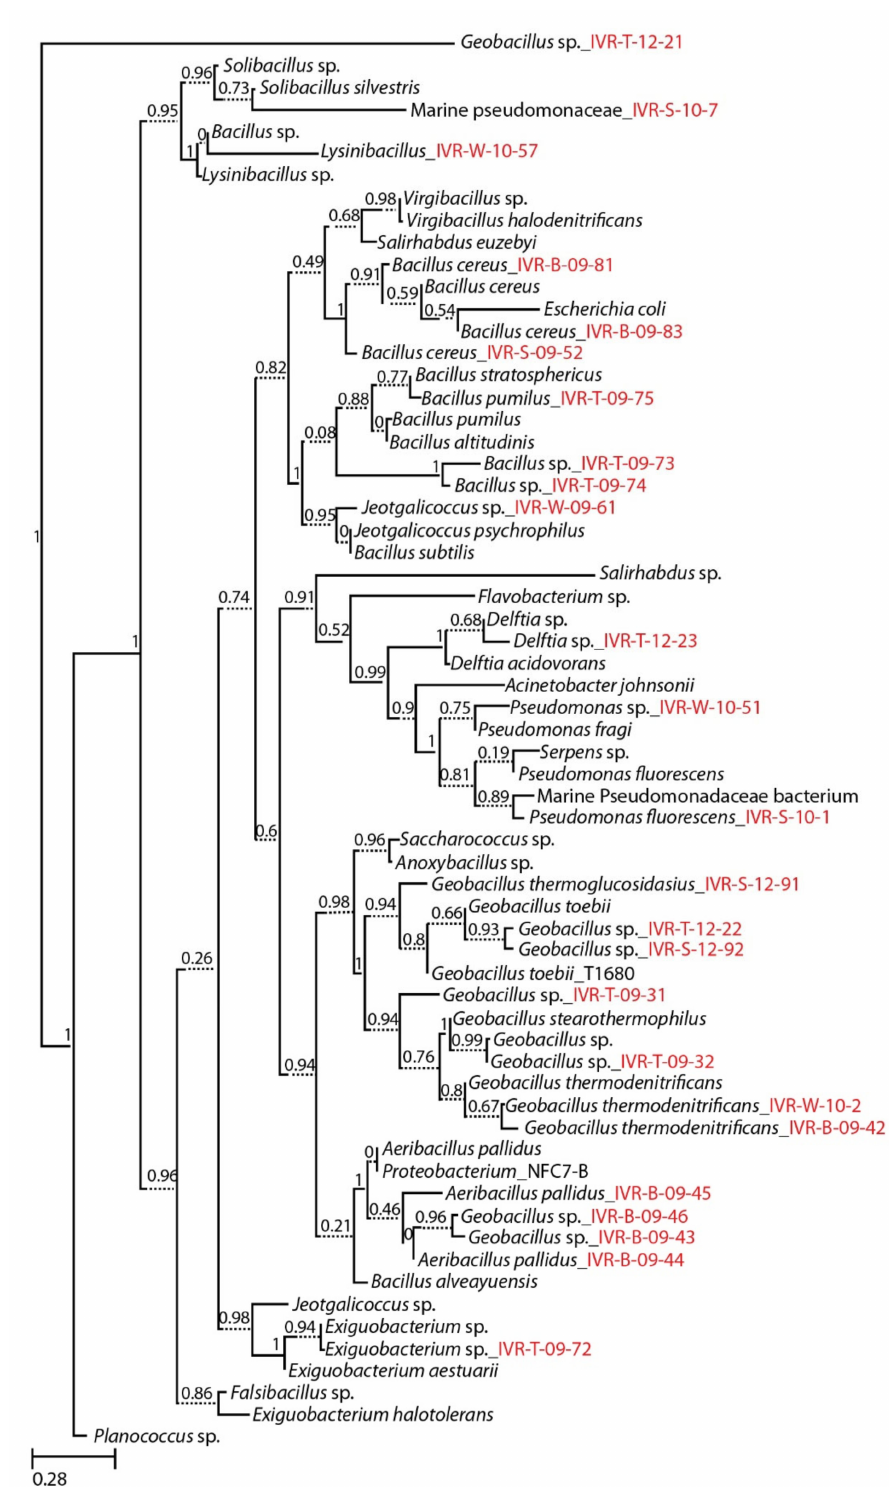
Figure 2. Molecular phylogeny of cultured marine bacterial strains from the Veracruz Reef System constructed by Maximum Likelihood with reference to the 16S rRNA gene sequences from the RDP data base. Numbers at nodes indicate percentages of occurrence in 1000 bootstrapped trees. The scale bar indicates evolutionary distance (0.28 substitutions per site). Strains sequenced in this study are denoted by isolate numbers in